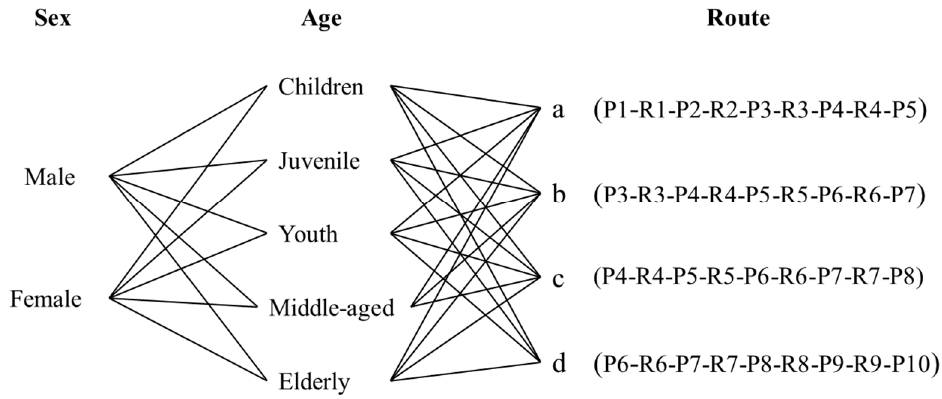
Figure 4. Inhalation intake evaluation scenarios.